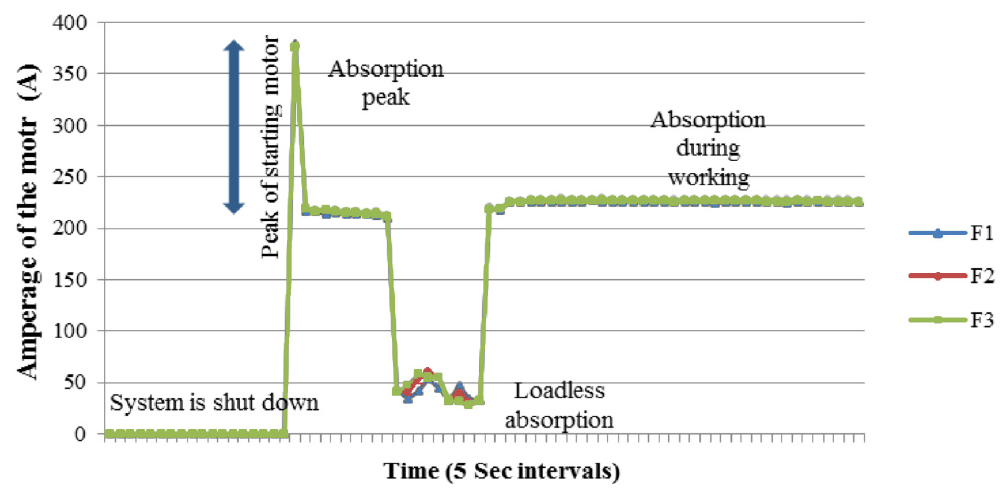
Figure 4. Absorption trend of the old motor before failure.